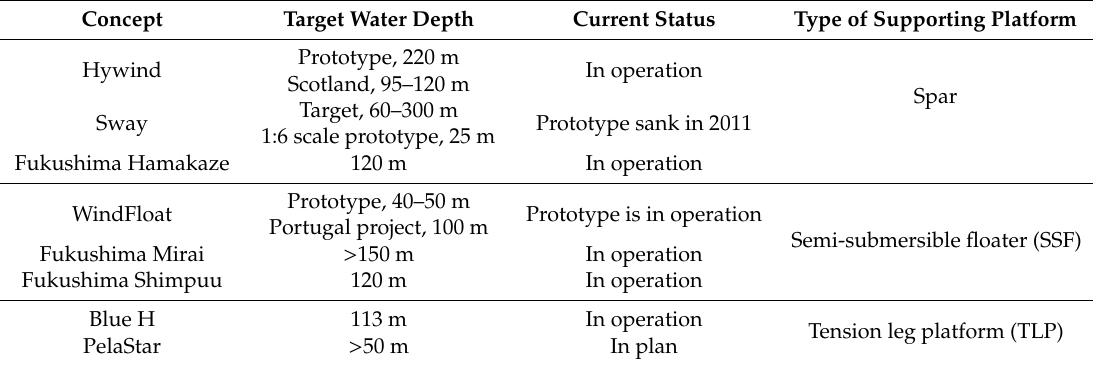
Figure 2. State-of-the-art of some existing floating wind turbines. Table 1. Brief review of existing floating wind turbines.